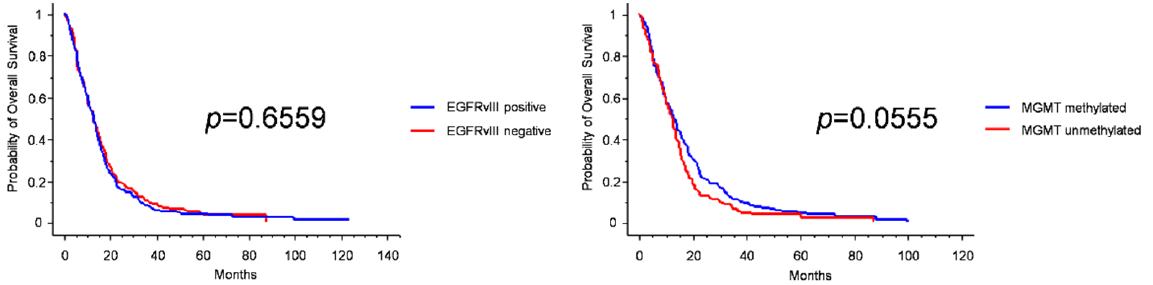
Figure 2. Kaplan–Meier survival curves for EGFRvIII expression ( left ), and MGMT promoter meth- ylation ( right ).